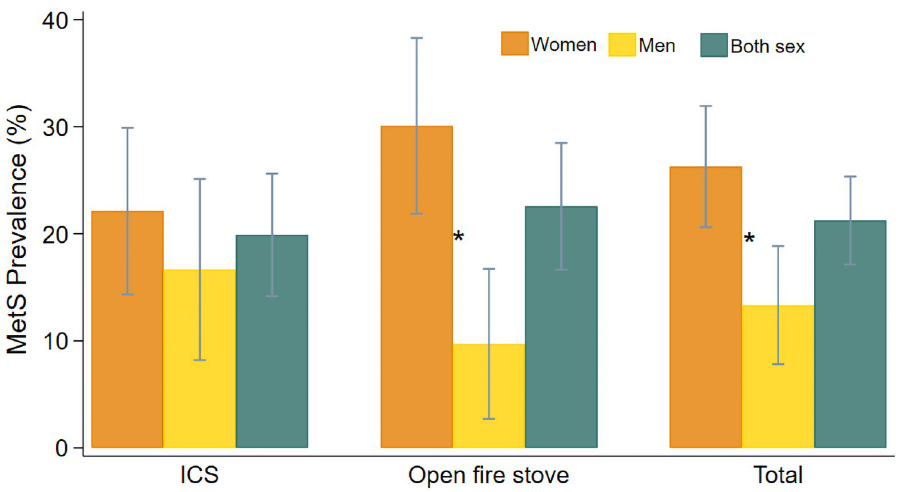
Fig 2. Prevalence and 95% confidence intervals of metabolic syndrome (MetS) among improved coosktove and open fire stove users of the provinces of San Marcos and Cajabamba, Cajamarca-Peru. � p-value < 0.05, Pearson Chi squared